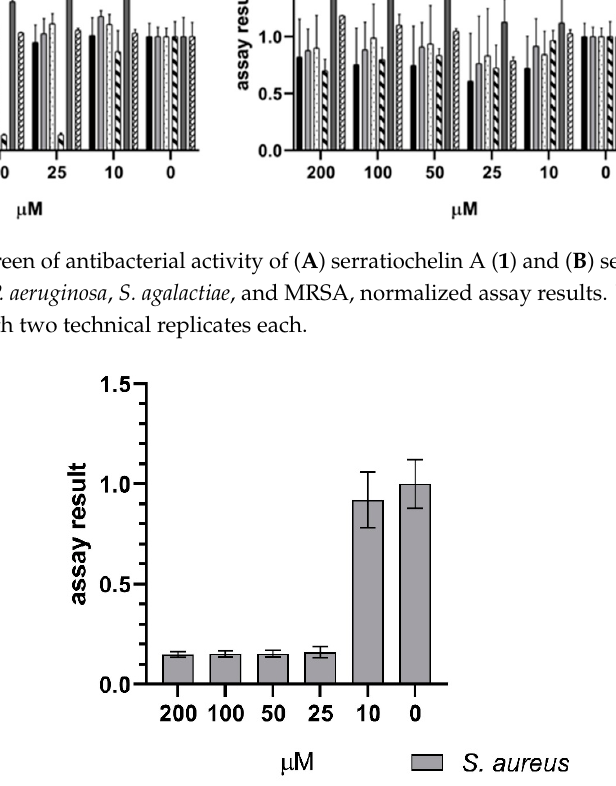
Figure 8. Effect of serratiochelin A ( 1 ) on S. aureus showing inhibition of growth down to 25 µM, normalized assay results. The assay was executed in four experiments with 3 × 2 and 1 × 3 technical replicates.